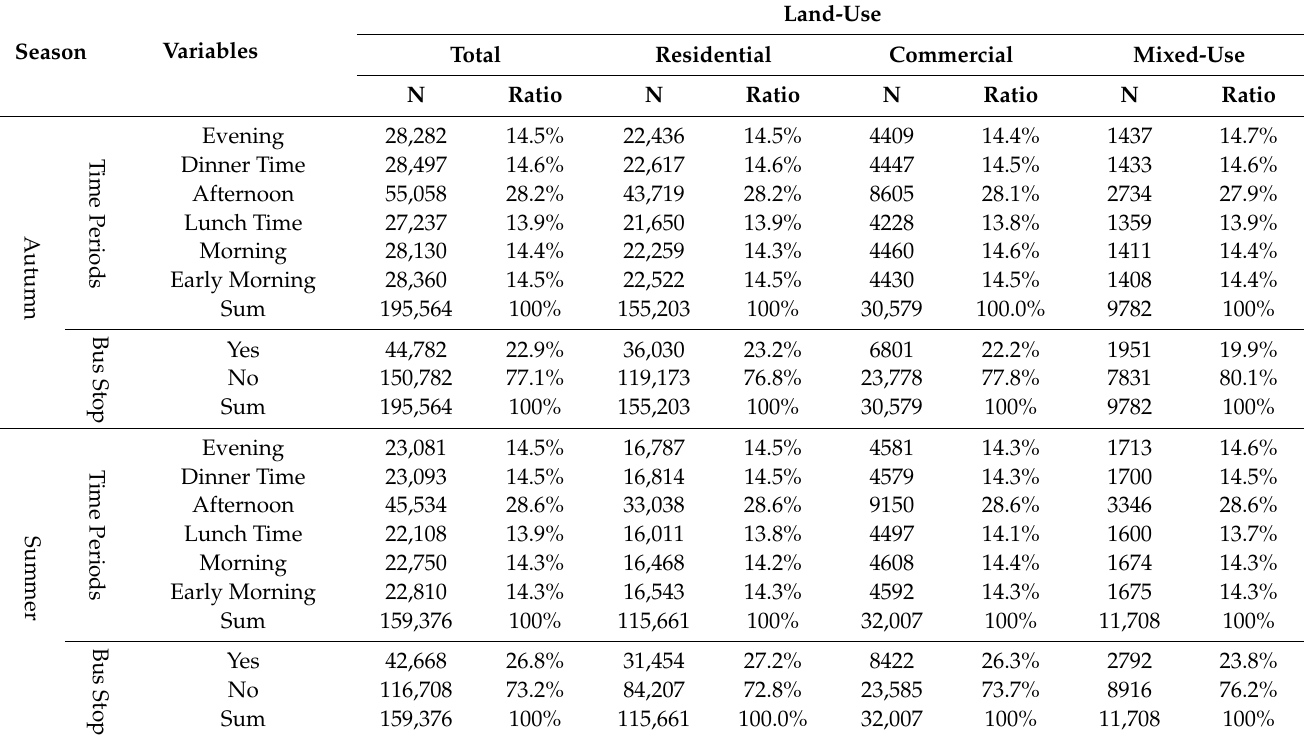
Table 7. Descriptive statistics for the nominal scale